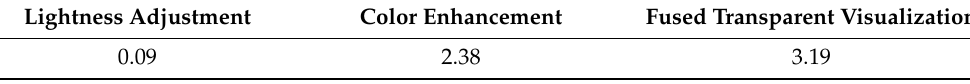
Table 1. Average computation time for each process of the proposed method (in